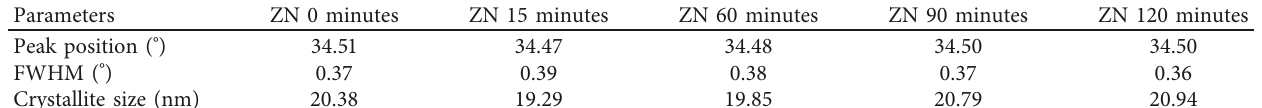
Figure 6: XRD profiles of ZnO NRs grown from the ZN source with the growth time t at 0, 15, 60, 90, and 120 Table 3: FWHM analysis of the (002) XRD peak in ZnO NRs grown from the ZN source.